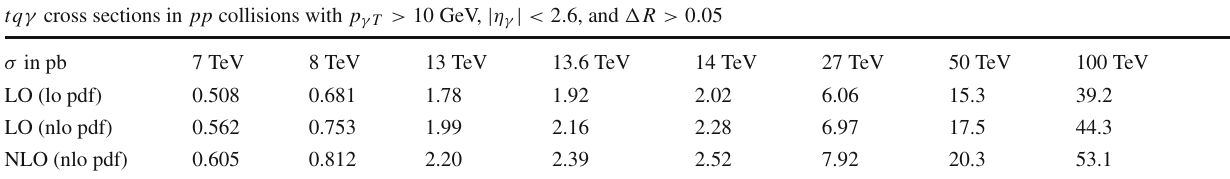
√ S = 7, 8, 13, 13.6, 14, 27,